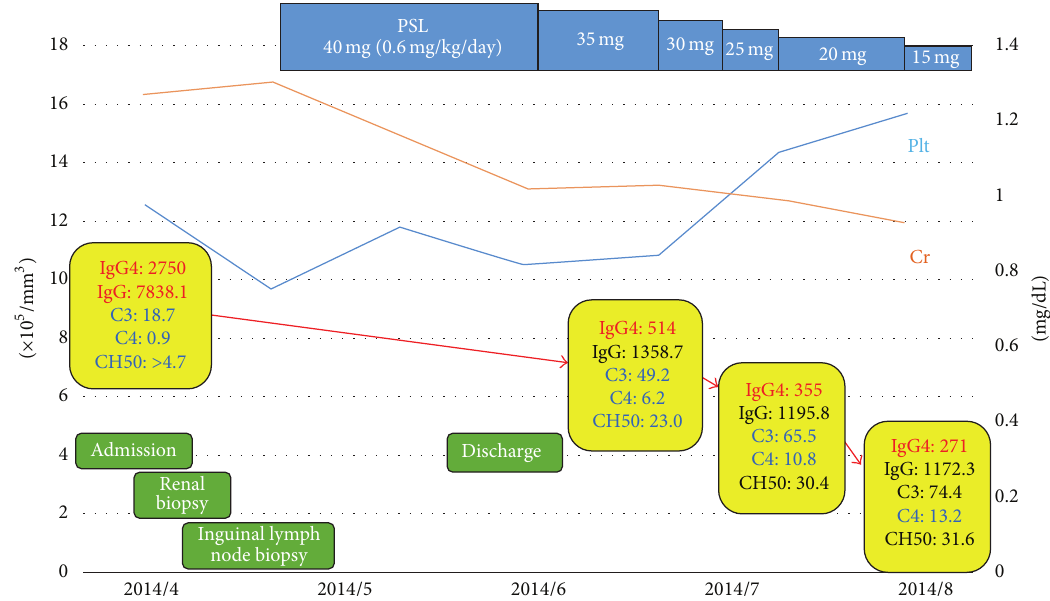
Figure 5: Clinical course of the patient. After admission in April 2014, renal and inguinal lymph node biopsies were performed. We diagnosed IgG4-RD by clinical findings, high level of IgG4, and histological findings in kidney and inguinal lymph node; then prednisolone (0.6 mg/kg/day) was started as therapy. Swelling of the salivary glands improved rapidly and pancytopenia and renal disorder likewise showed improvement. The high levels of serum IgG and IgG4 and hypocomplementemia all also showed marked improvement. These improvements continued until August 2014. The prednisolone dose could be gradually